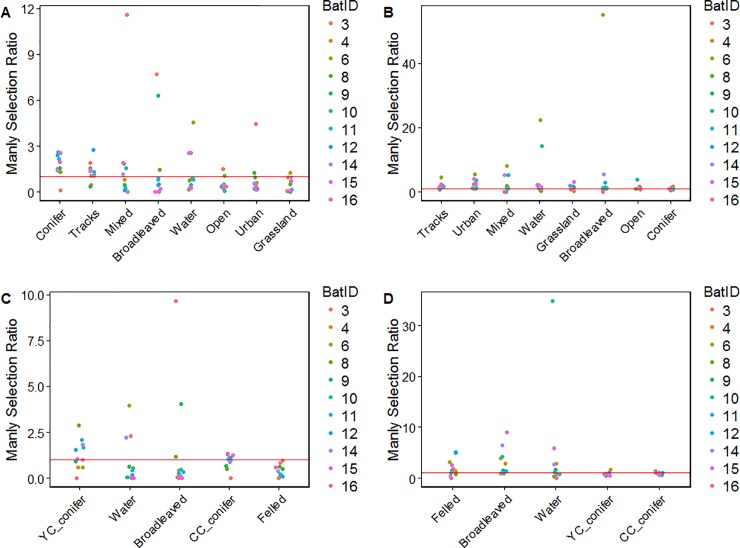
Individual Manly selection ratios for all bats at both the landscape scale using the broad (A) and fine (C) resolution habitat classifications, and local scale using the broad (B) and fine (D) resolution habitat classifications. Habitats are ranked from left to right according to the number of individuals which positively selected that habitat type. Points are coloured by bat ID. The red line indicates the point at which no selection or avoidance is occurring, above the red line indicates selection of that habitat type, below the red line indicates avoidance of that habitat type. YC conifer refers to young conifer, CC conifer refers to closed canopy conifer. See Table A in S1 Appendix for description of different stand types.